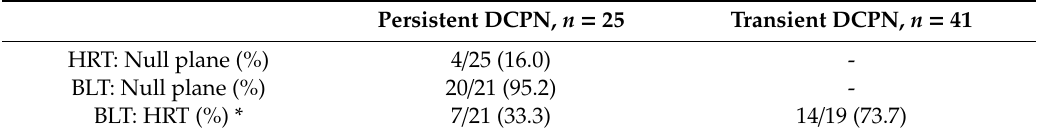
Table 3. Analysis of bow and lean test (BLT), head roll test (HRT) and the side of null plane between persistent and transient geotropic DCPN (direction-changing positional